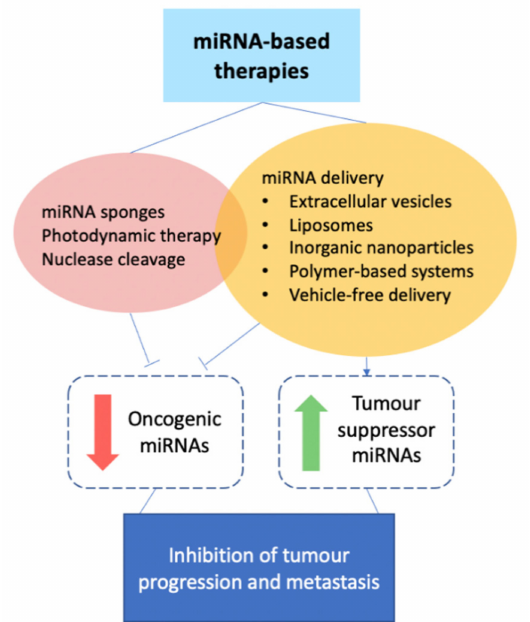
Figure 4. Summary of approaches taken in miRNA-based therapies for breast